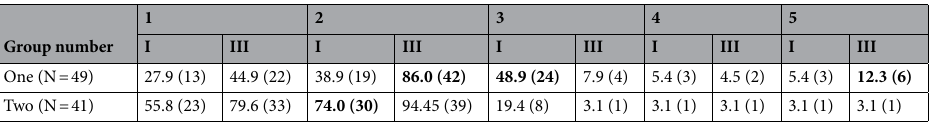
Table 1. Parameters of reading technique in forms I–III (Russian and Kazakh population, mean), % + (the number of children). Significant changes are highlighted in bold (P ≤ 0.05), I, III—forms; 1—number of words per minute; 2—ability to read words or combinations of words; 3—ability to read with syllables; 4—reading mistakes; 5—reading